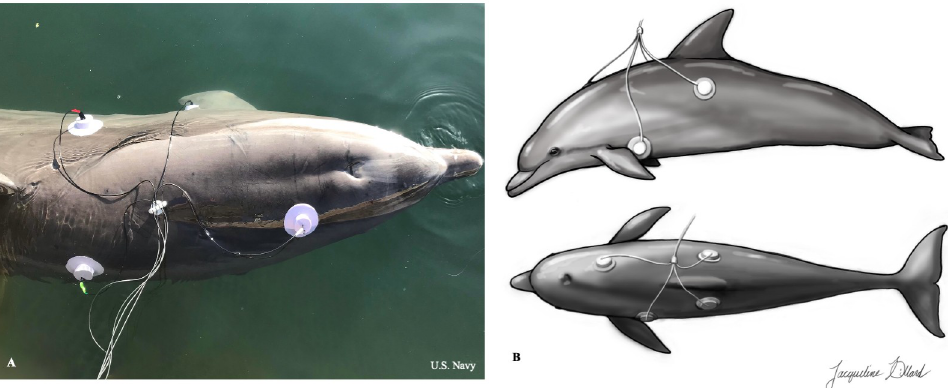
Fig 2. Telemetric four-electrode six-vector ECG with modified base-apex lead placement. (A) A trained Navy dolphin demonstrating the modified base-apex lead placement utilized for telemetric ECG. (Republished from the U.S. Navy under a CC BY license, with permission from U.S. Navy, original copyright 2021.) (B) Illustration of modified base-apex lead placement on a dolphin (illustrated by Jacqueline